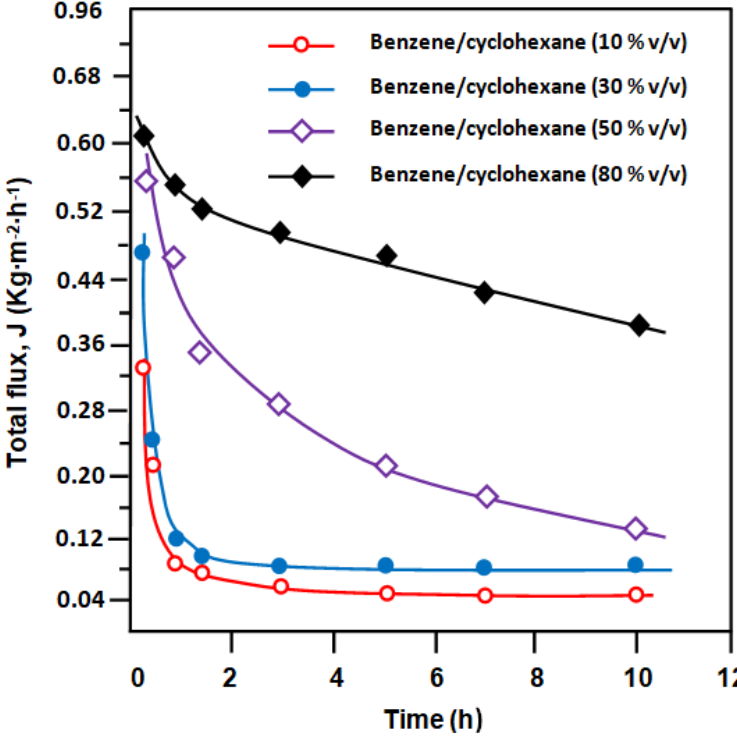
Figure 9. Change in permeate total flux for benzene/cyclohexane mixtures with different compositions versus time using the E-VOH-membrane.